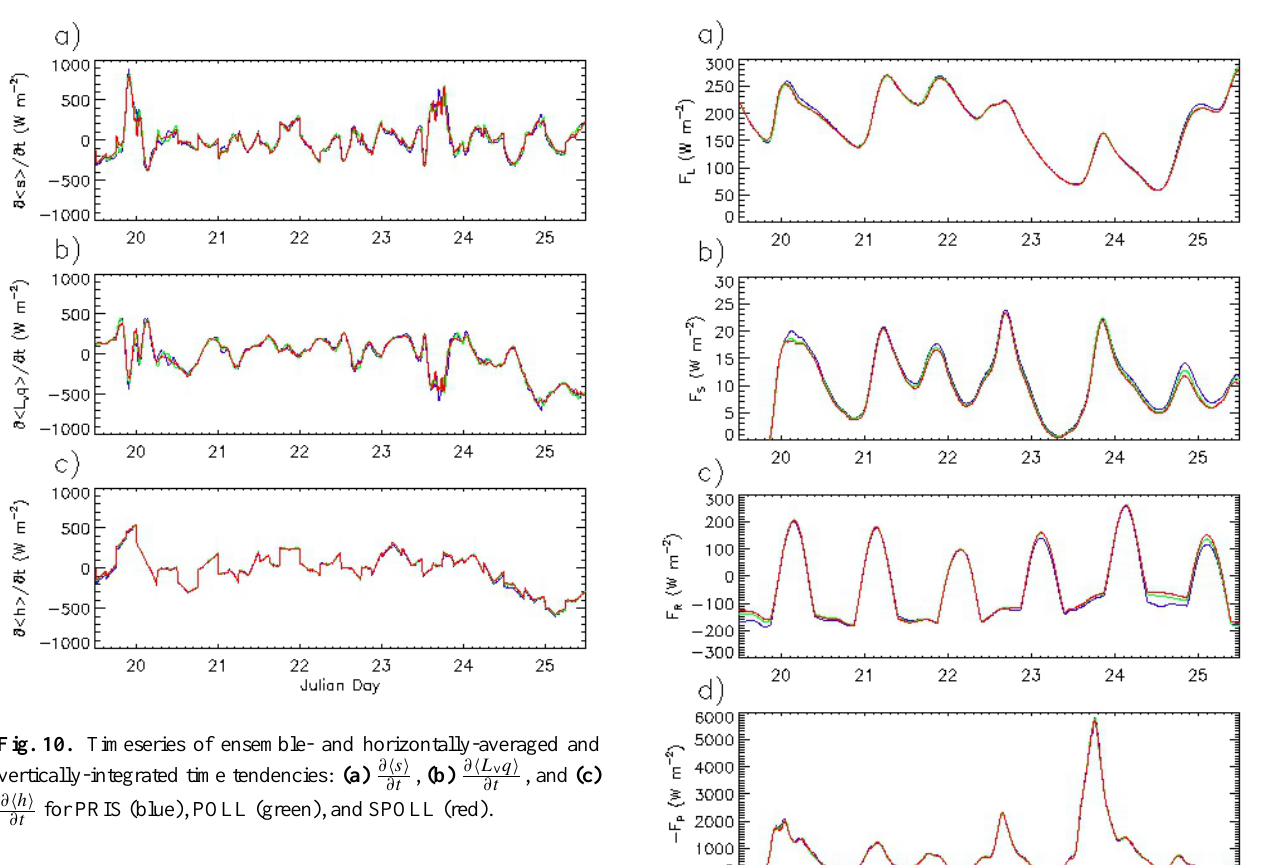
microphysical processes (for example, there is decreased rain evaporation with a reduction of q r and N r ) similar to the findings of Grabowski (2006), Slawinska et al. (2009), and Grabowski and Morrison (2011).